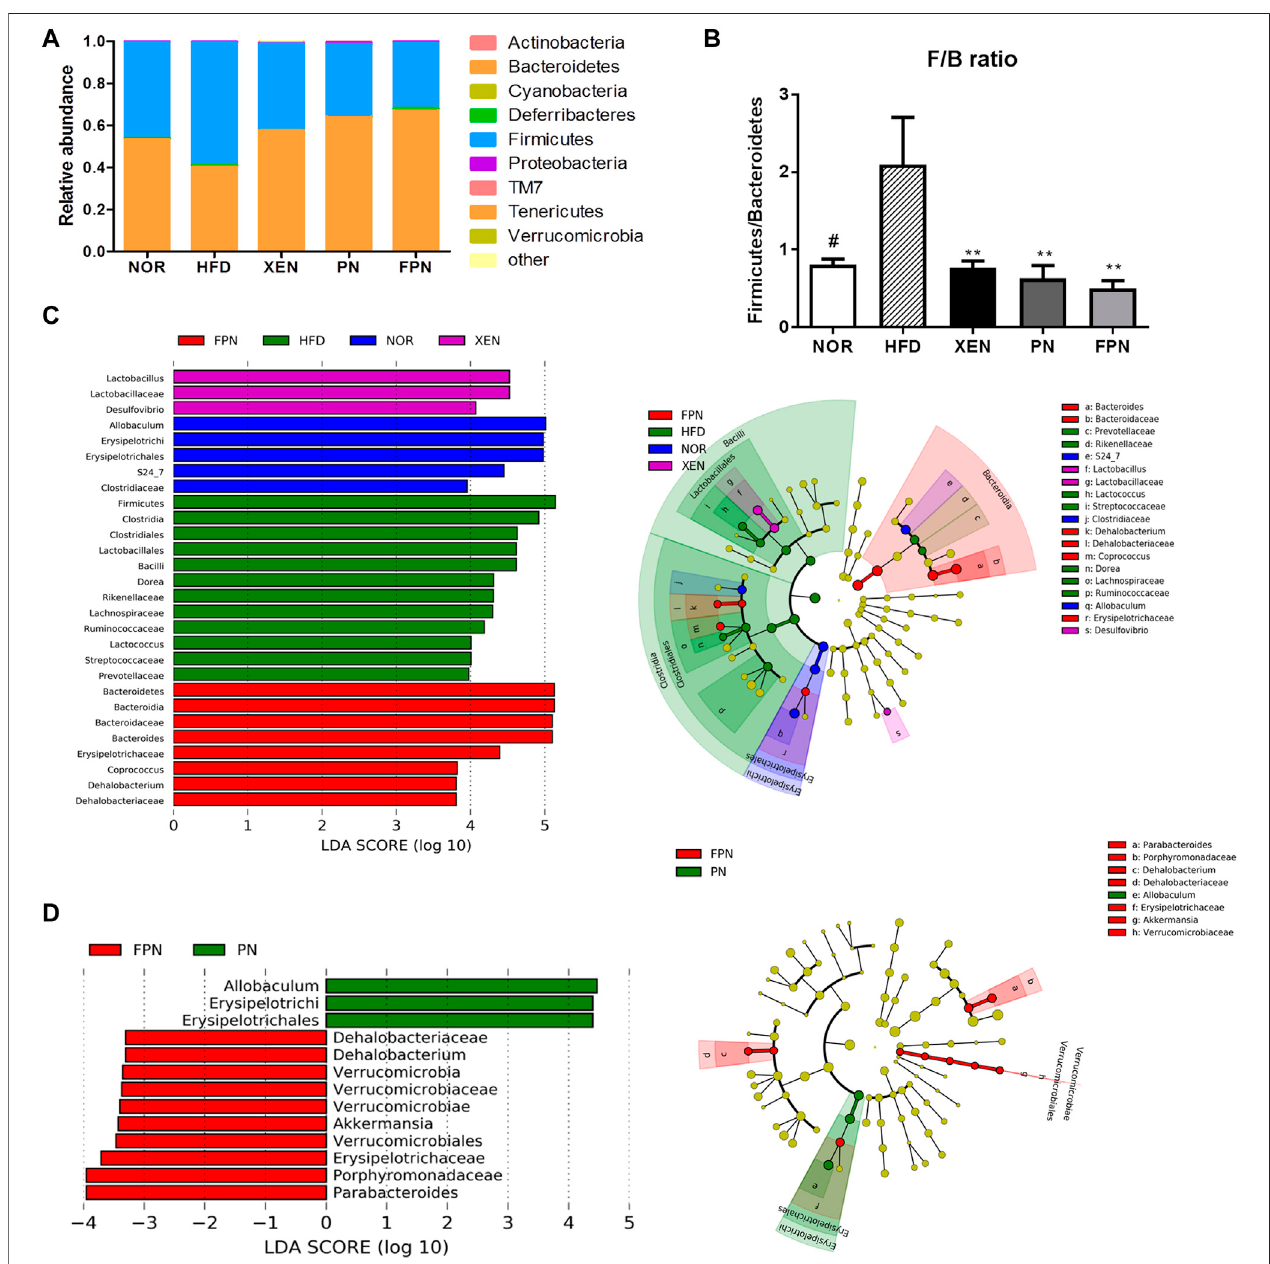
FIGURE 8 | Inter-group variations in the relative abundances of the gut microbial communities in the HFD-induced mouse model after treatment for 9 weeks. (A) relativeabundancesatthephylumlevel, (B) relativeabundanceofBacteroidetesandFirmicutesineachgroup, (C) ataxonomiccomparisonofthebacterialcommunities amongallgroupsand between (D) PNand FPNgroups. Signi fi cantdifferences intheLDA scores( p < 0.05) wereproduced amongtheclasses (Kruskal-Wallistest).The threshold of the logarithmic LDA score was > 2.0.